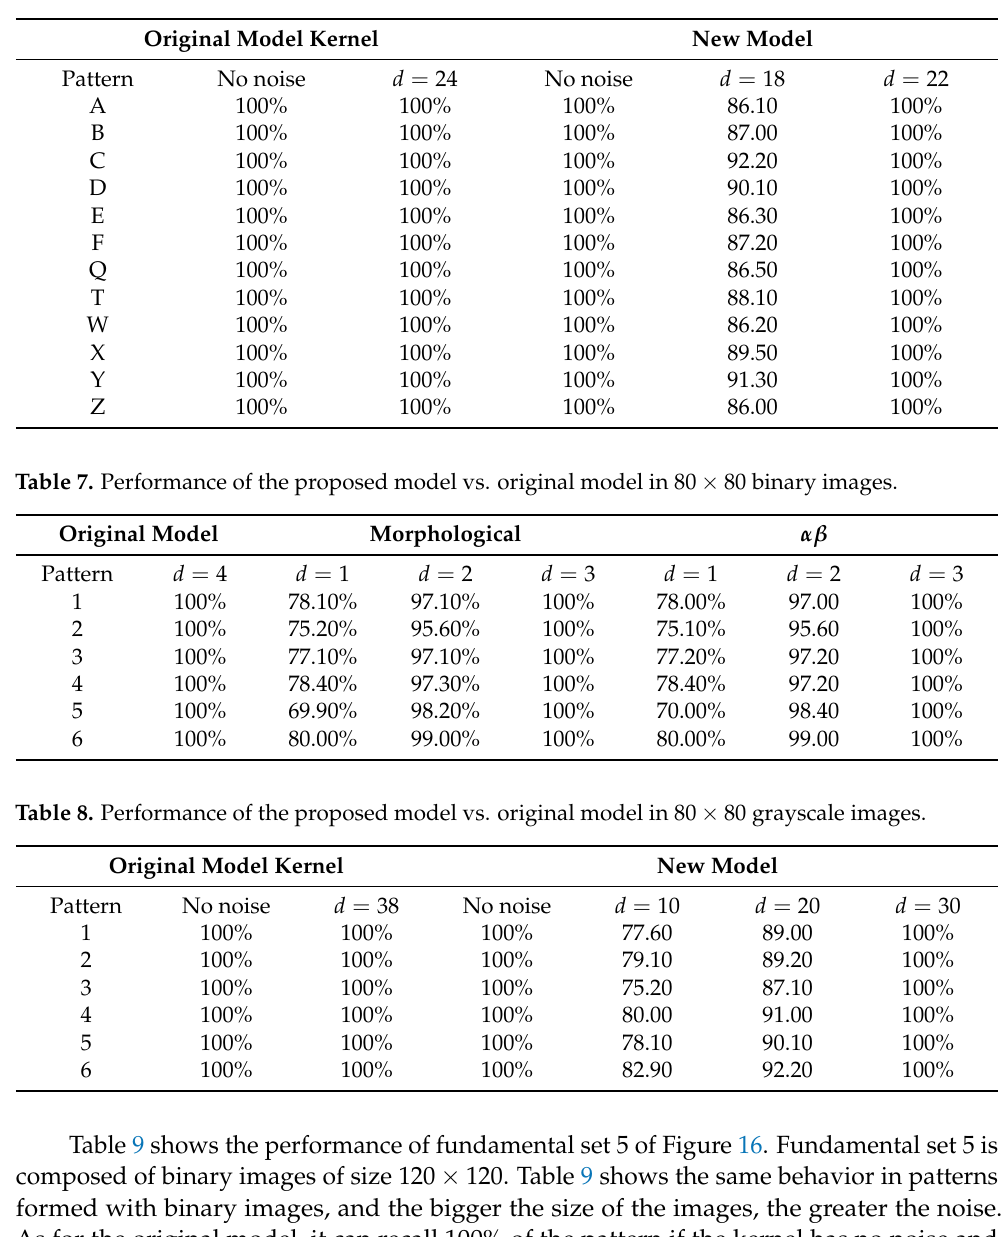
Table 6. Performance of the proposed model vs. original model in 50 × 50 grayscale images.